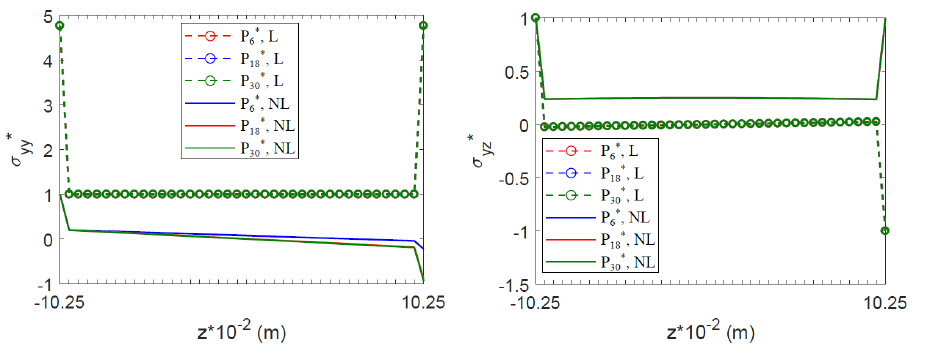
Figure 25. Distribution of axial and shear stress components for P ∗ = − 0.082, P ∗ = − 0.1, and P ∗ = − 0.105 values in L9 extensions at x = − a 2 /2 and y = L /2 in the two-cell FG beam sub- jected to axial loading for m = 5.0, ( σ ∗ yy = σ yy / σ yy